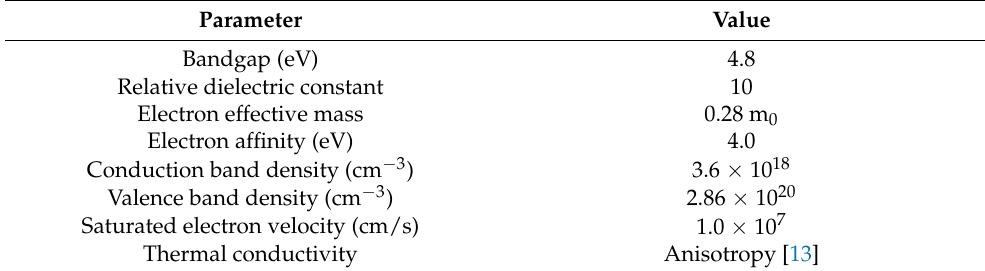
Table 1. β -Ga 2 O 3 simulation